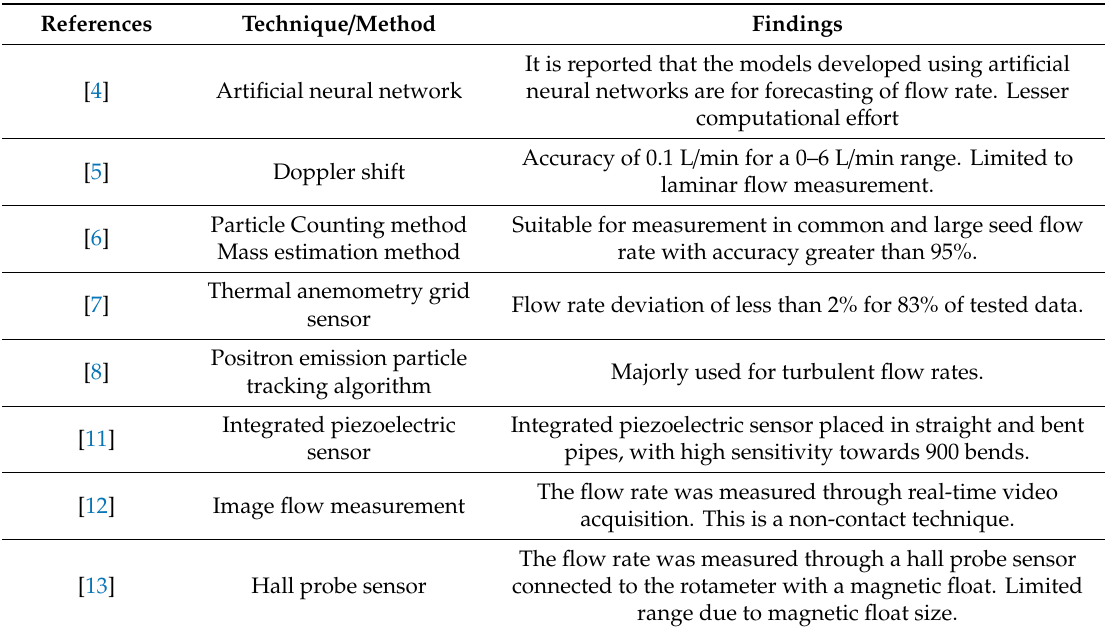
Table 1. Comparison of techniques used for flow